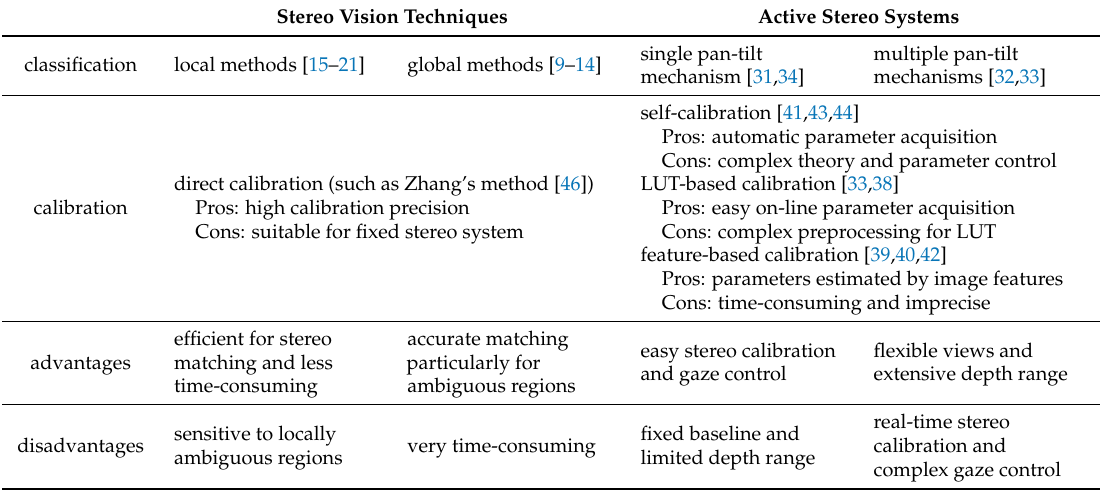
Table 1. Pros and cons of stereo vision techniques and active stereo